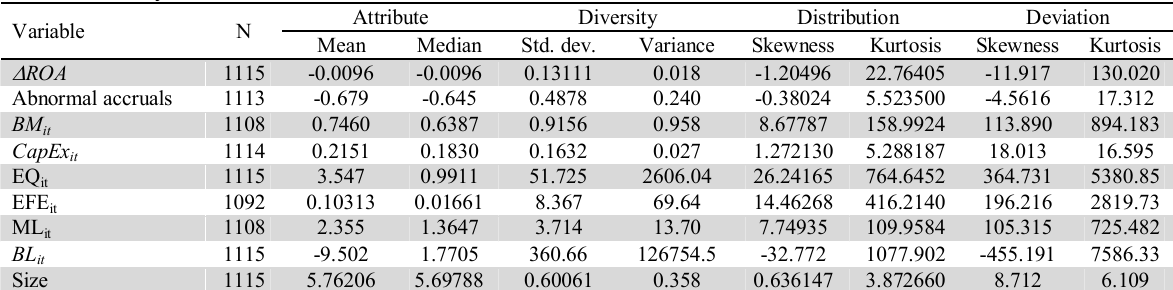
The summary of basic